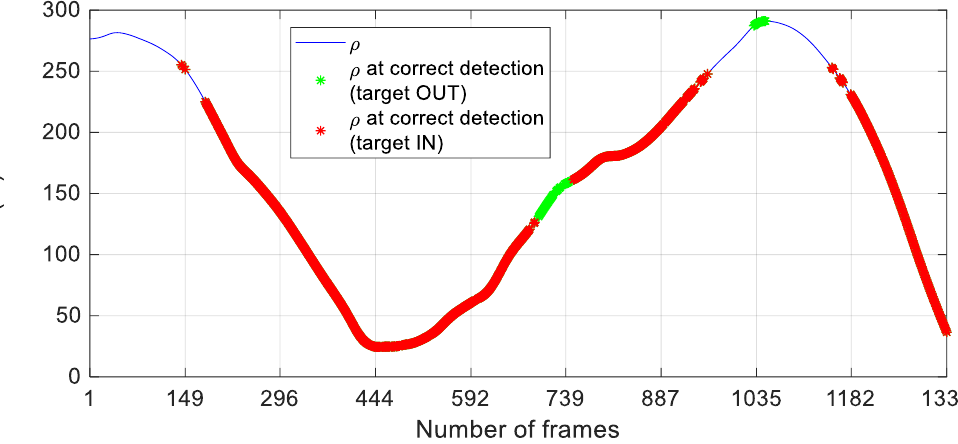
Figure 15. Variation of the target-chaser relative distance (blue line) during the FT1-B (1330 images). The DL-based detector and tracker are applied setting τ det to 0.20 and τ tr to 0.075. The frames where the algorithmic architecture provides correct detections are highlighted with red (target inside the FOV) and green (target outside the FOV) stars.